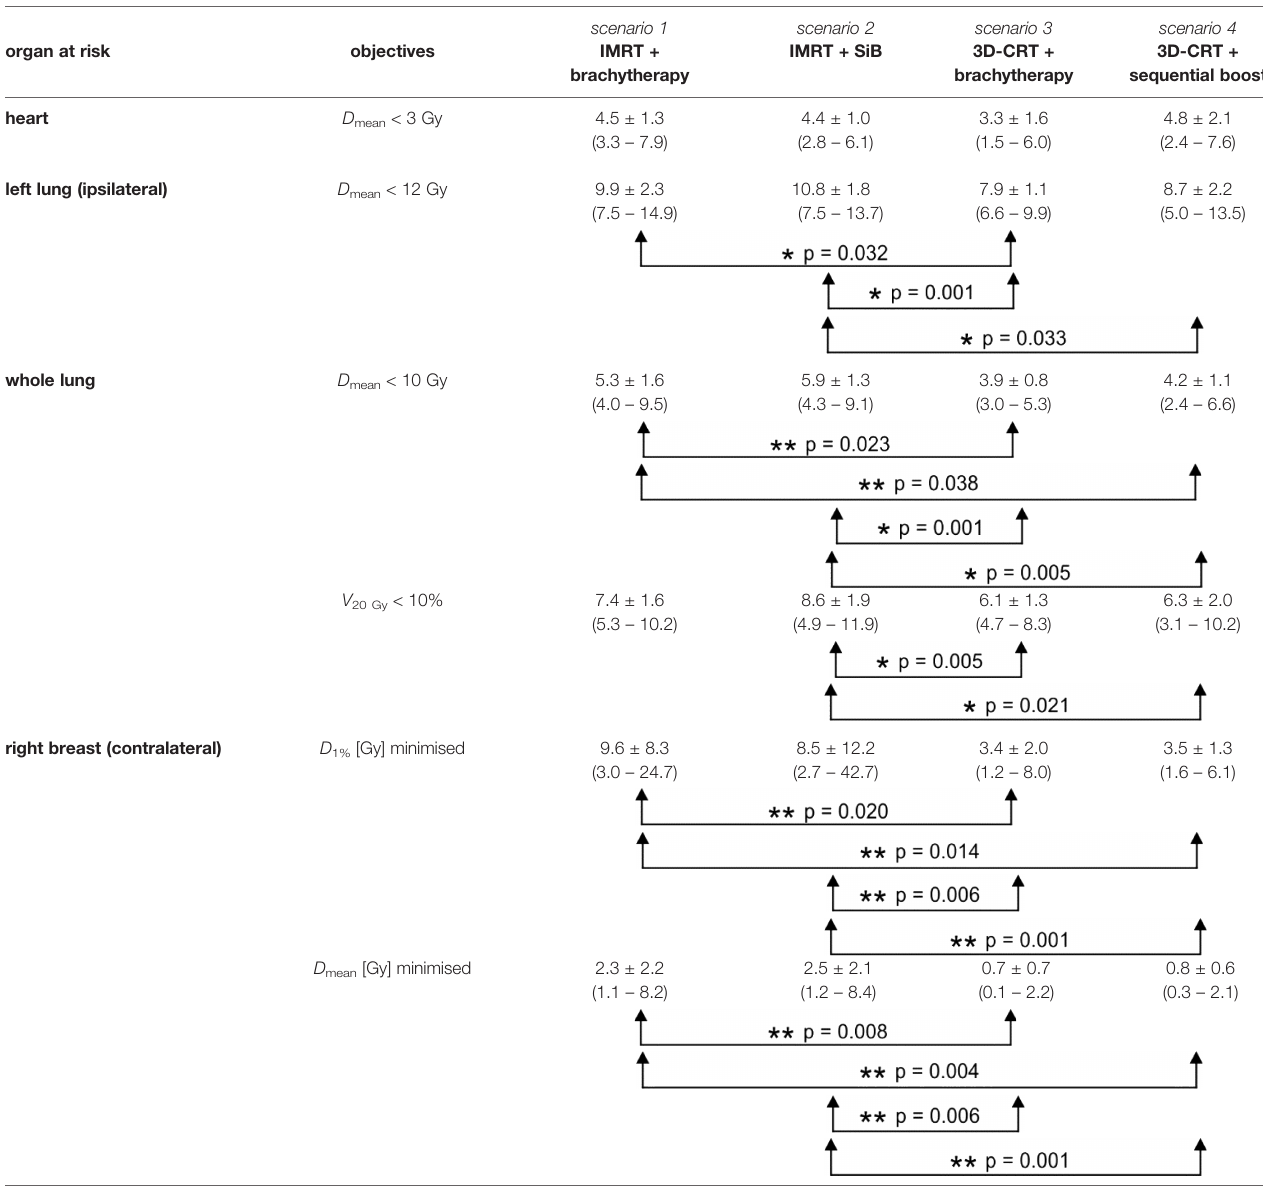
TABLE 1 | Organs at risk TPS dose statistics versus planning